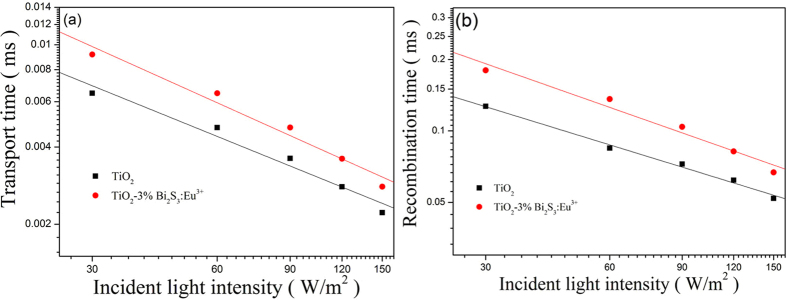
Comparison of (a) transport time constant and (b) recombination time constant for DSSCs comprised of pure TiO2 cell and TiO2-3%Bi2S3:Eu3+ cell.